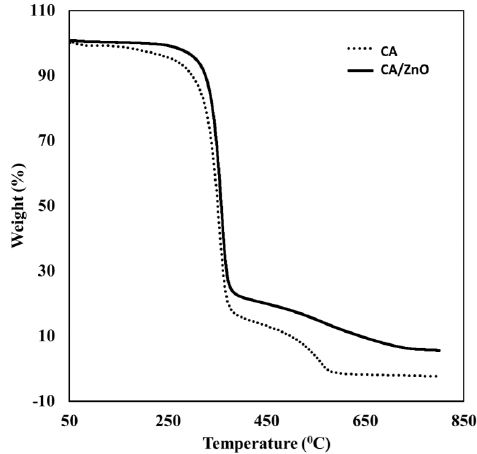
Figure 1. SEM microphotographs of membranes. ( a ) CA, ( b ) CA/ZnO.